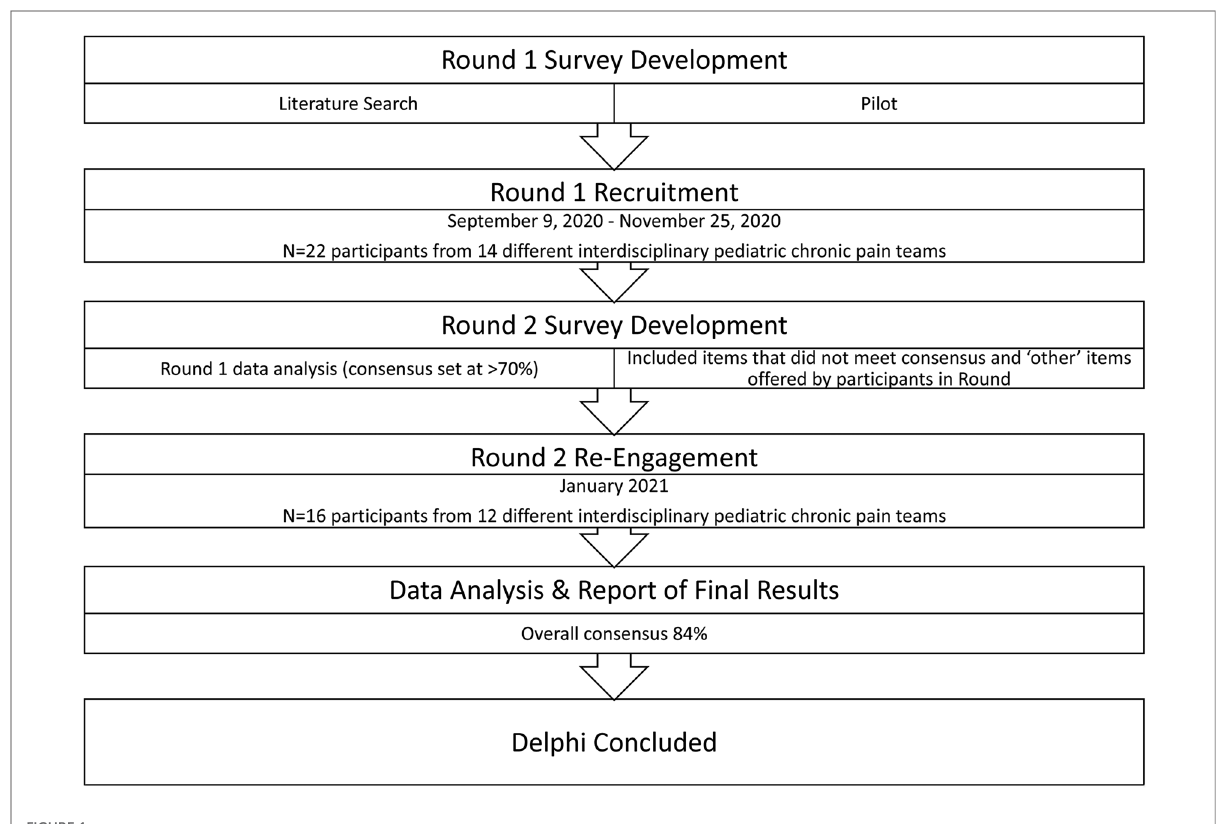
FIGURE 1 Delphi process fl